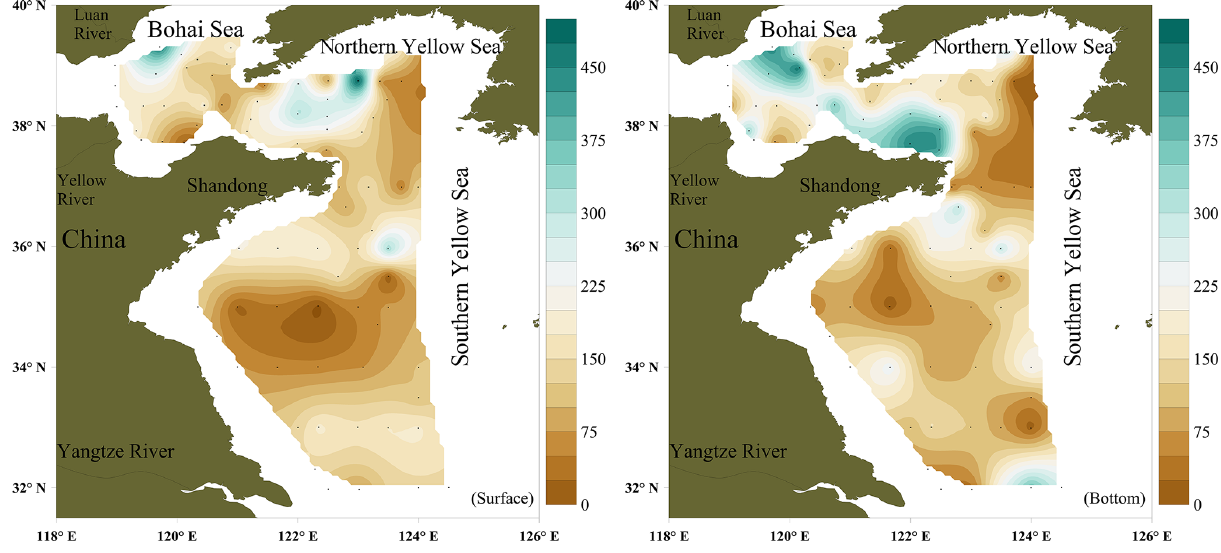
Figure 2. Horizontal distributions of NO (pmolL − 1 ) in the surface water and bottom water.